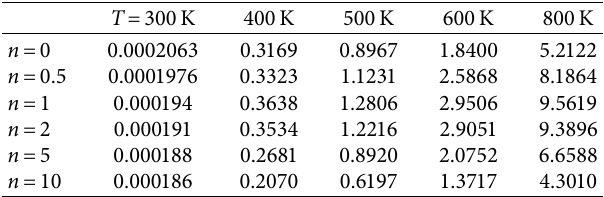
c (mm) depending on n